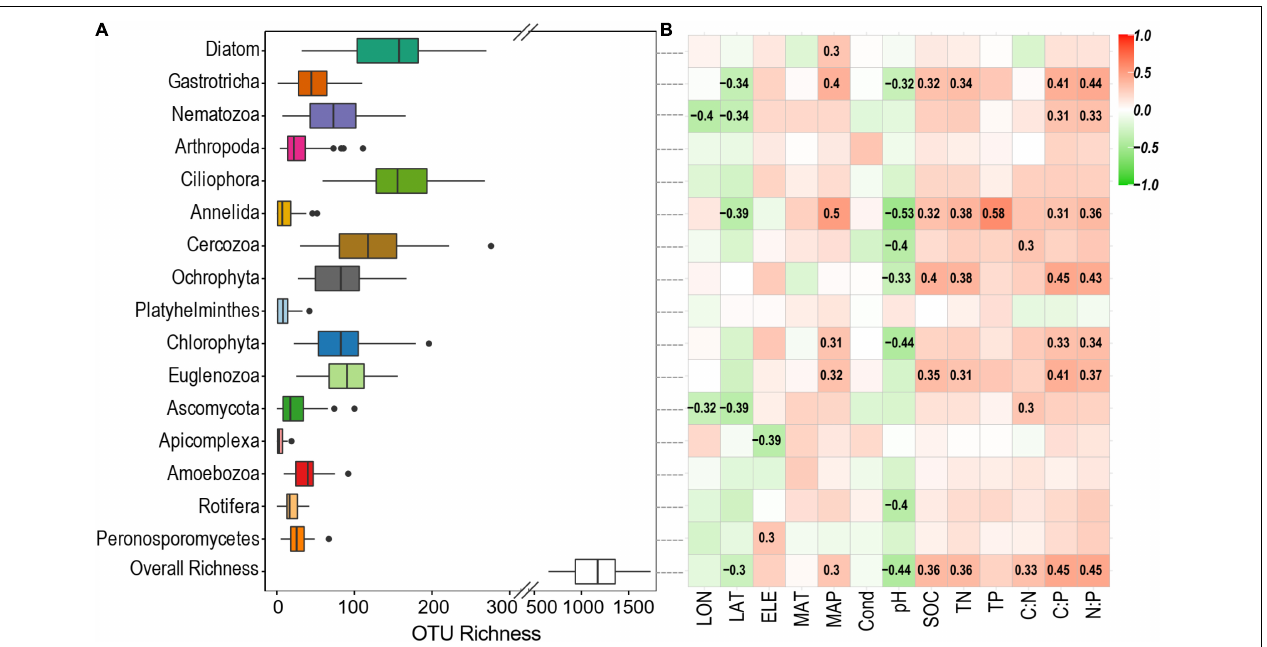
FIGURE 3 | (A) OTU richness of the overall micro-eukaryotic communities and major phylum. (B) Spearman correlations show the relationships between alpha diversity and environmental factors. The color represents the correlation coefficient, which is shown in number when the result is significant ( p < 0.05).